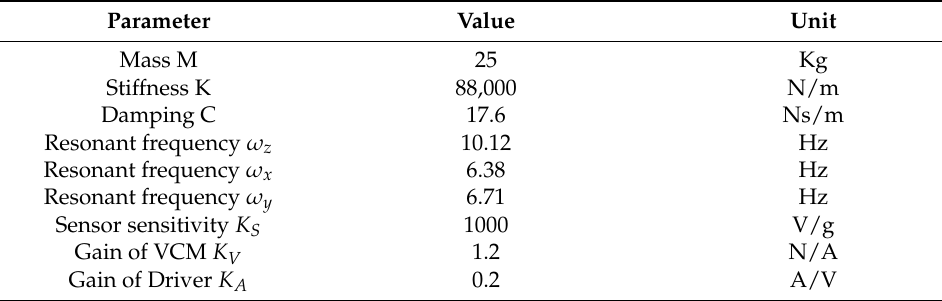
Table 3. Controller parameters of experimental